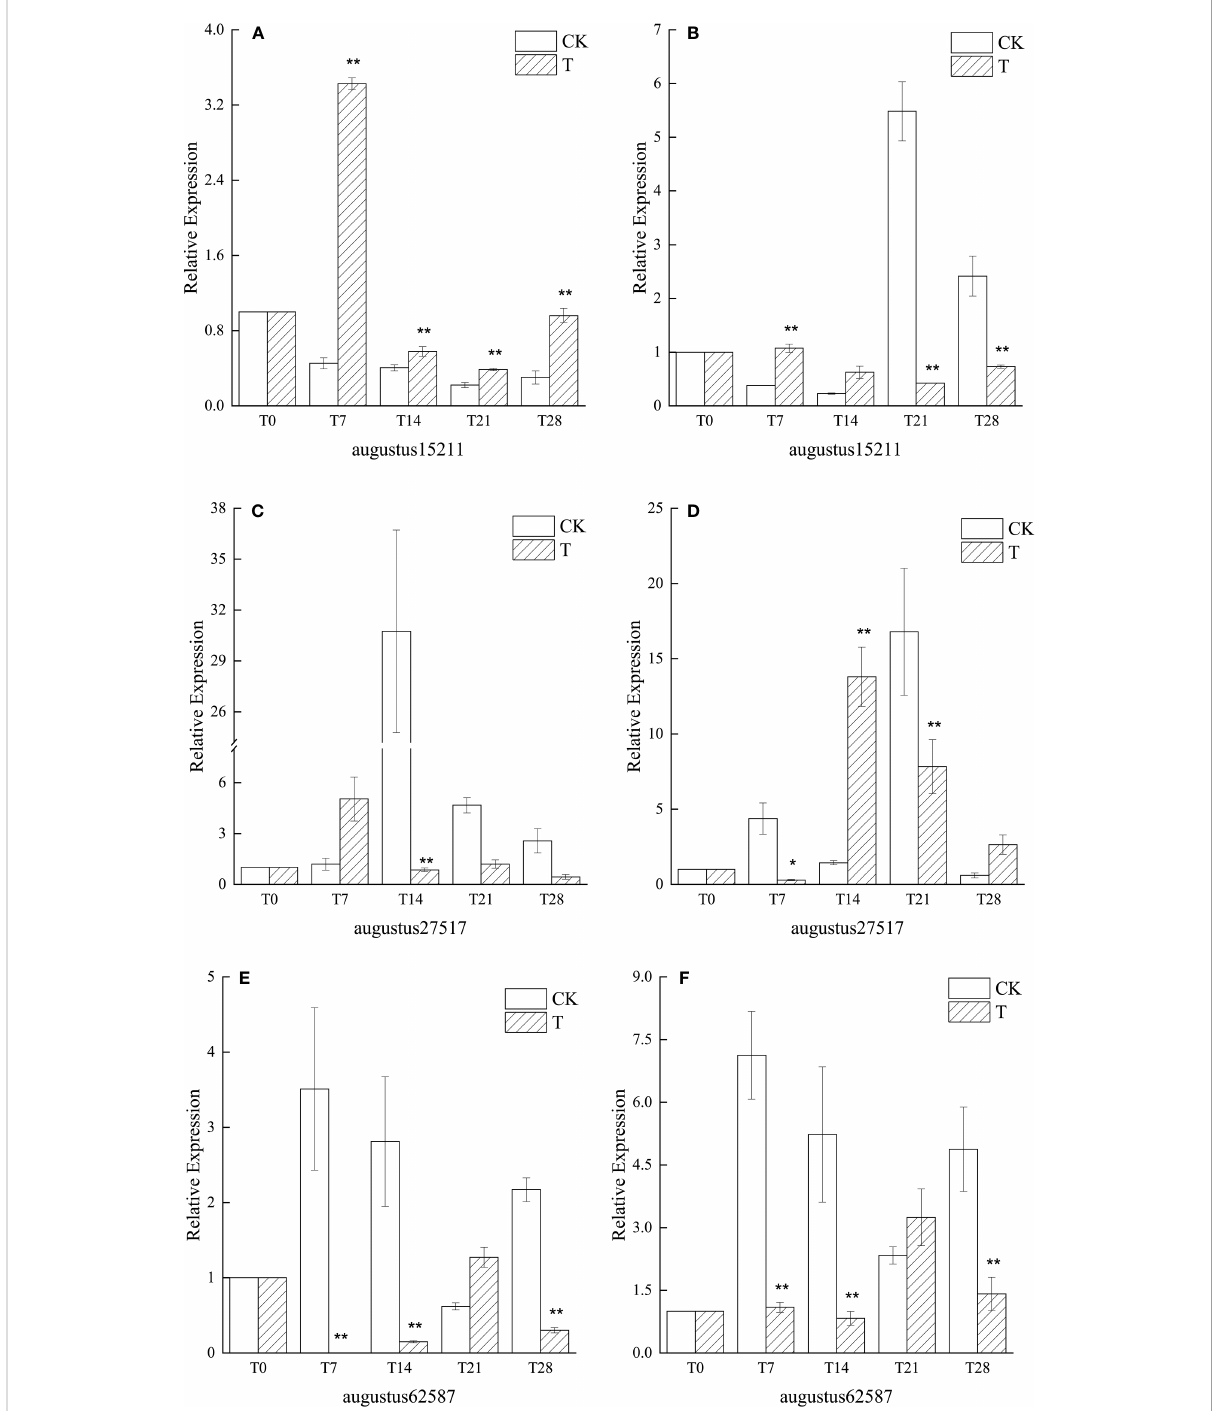
FIGURE 5 Relative expression of similar genes augustus15211, augustus27517, and augustus62587 of SVP , FLC , and TFL1 in leaves of plants with different treatments of L. chinense var. rubrum. ‘ (A) ’ , ‘ (C) ’ and ‘ (E) ’ represent the relative expressions of SVP , FLC and TFL1 similar genes in leaves of ‘ Xiangnong Xiangyun ’ under different treatments, respectively. ‘ (B) ’ , ‘ (D) ’ and ‘ (F) ’ represent the relative expression of similar genes of SVP , FLC and TFL1 of ‘ Hei Zhenzhu ’ in leaves under different treatments, respectively. ‘ T ’ represents the low-temperature treatment group and ‘ CK ’ represents the blank control group treated at 25°C. '*' signi fi cant difference, '**' extremely signi fi cant